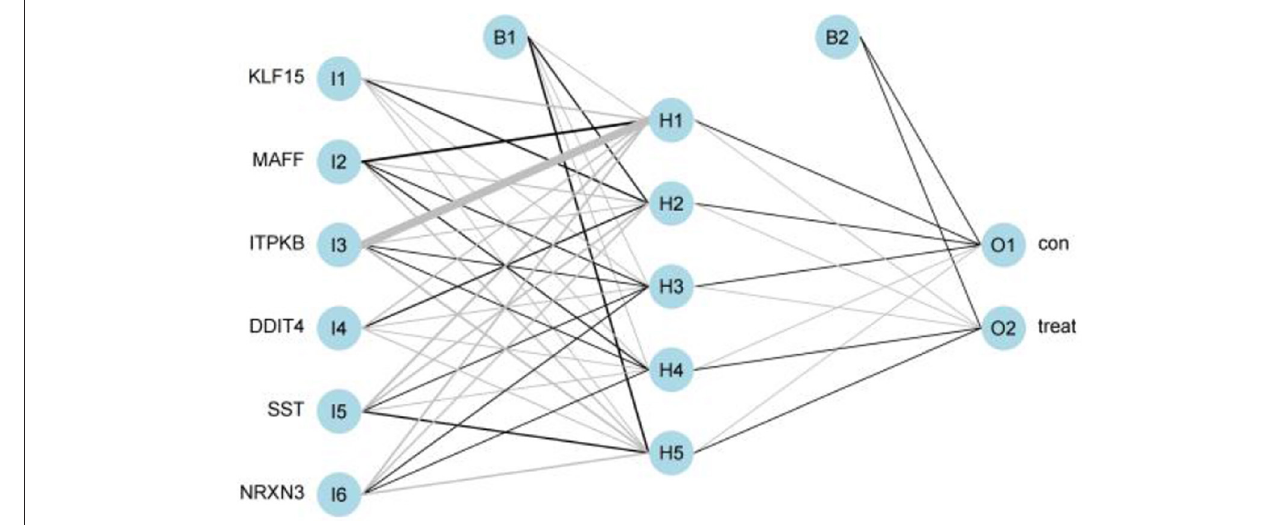
FIGURE 6 | Visualization of artificial neural networks’ results.